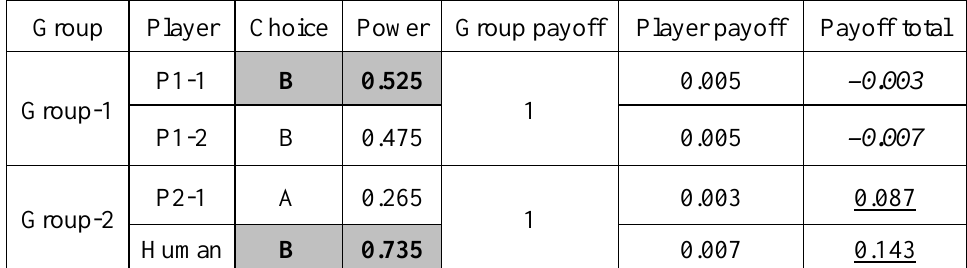
Table 2 . Example of feedback presented to the human participants after each round in the IPD^2